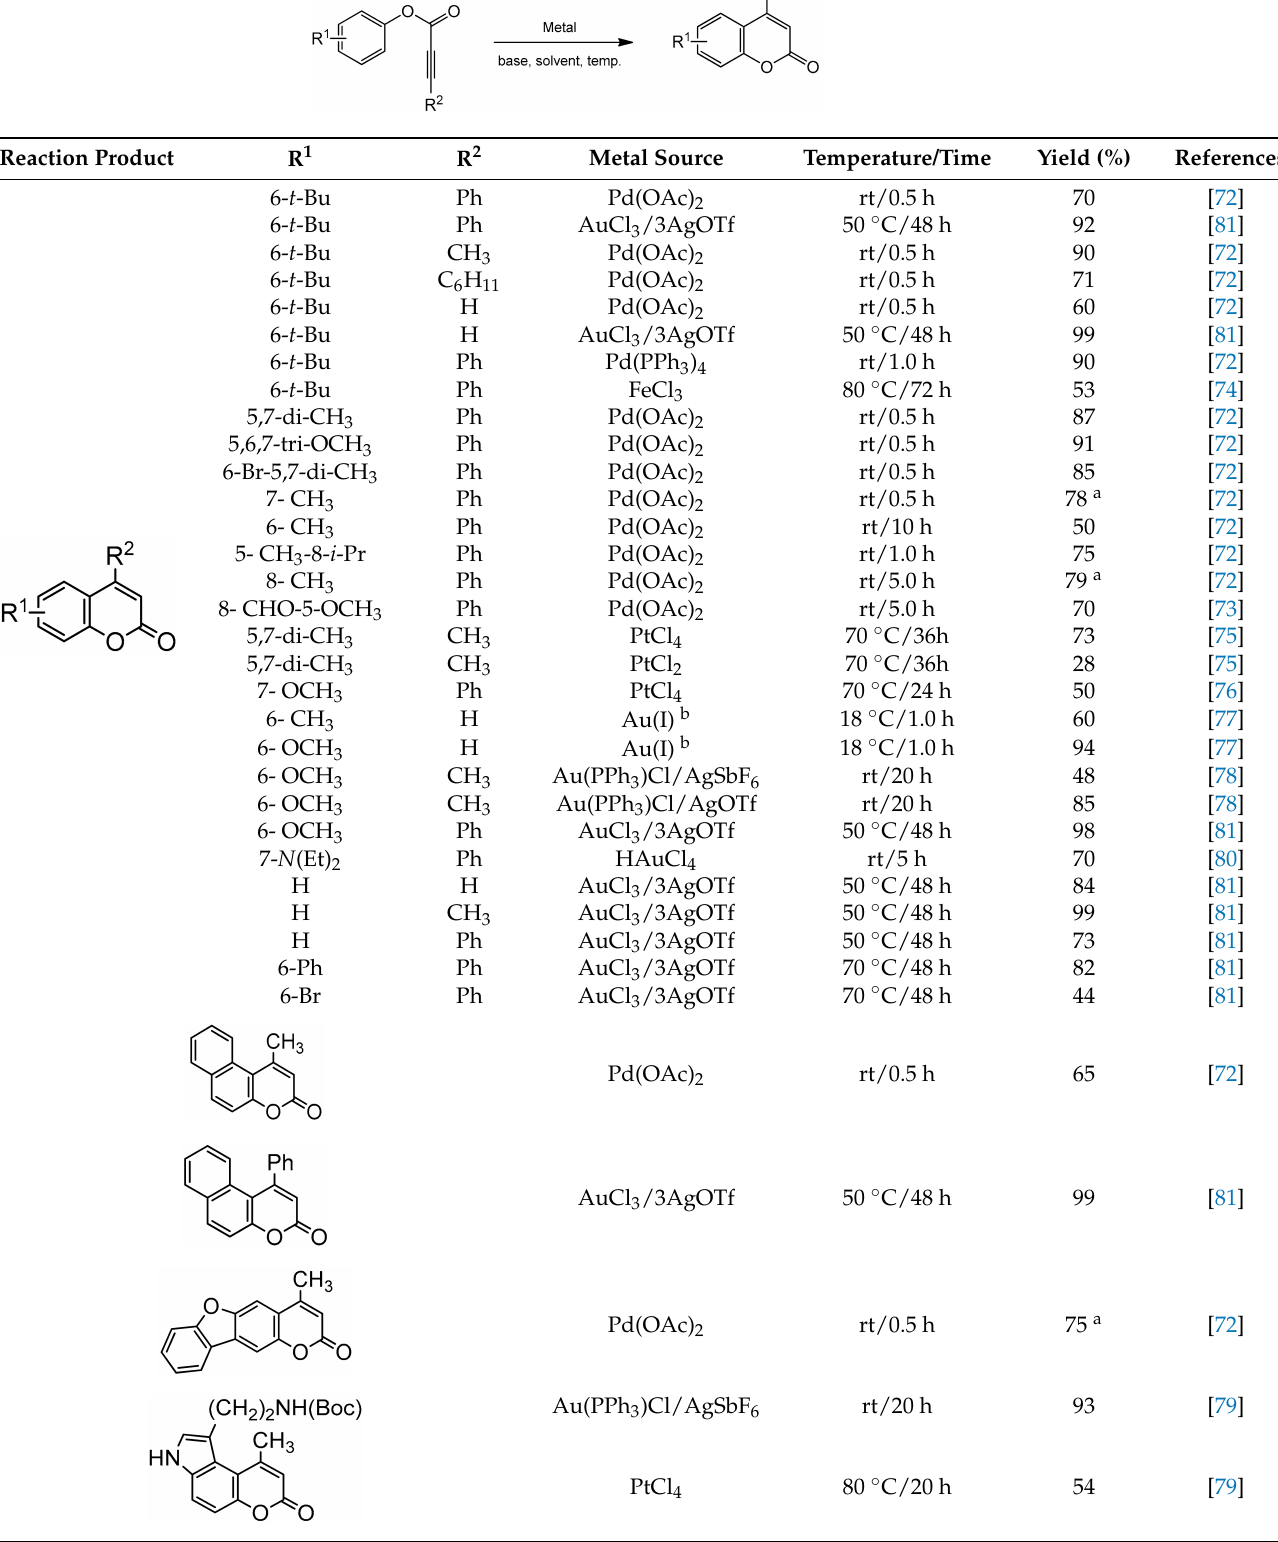
Table 2. Coumarins obtained via intramolecular